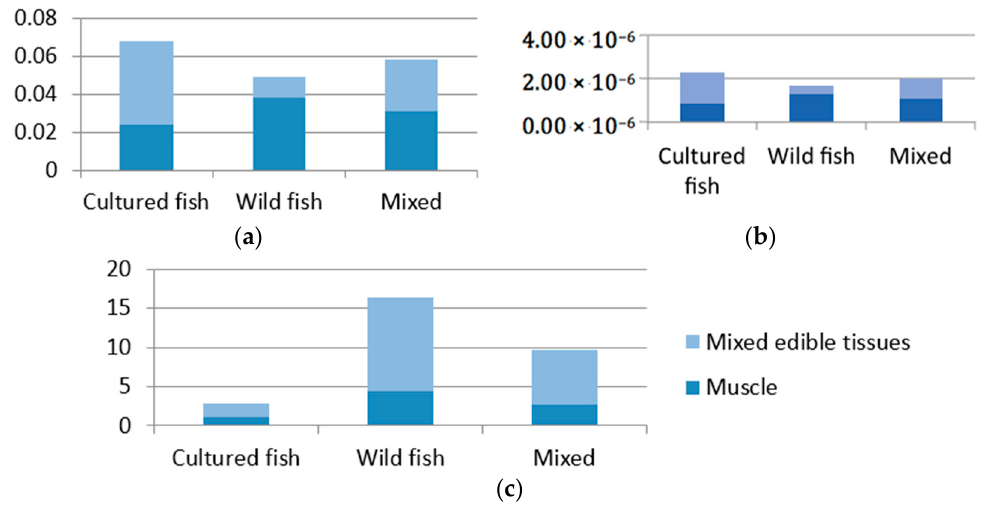
Figure 4. Calculation results of health risks through cultured, wild and mixed (wild:cultured = 1:1) fish muscle and mixed edible tissue consumption based on THQ ( a ), CR ( b ) and EWI ( c ).